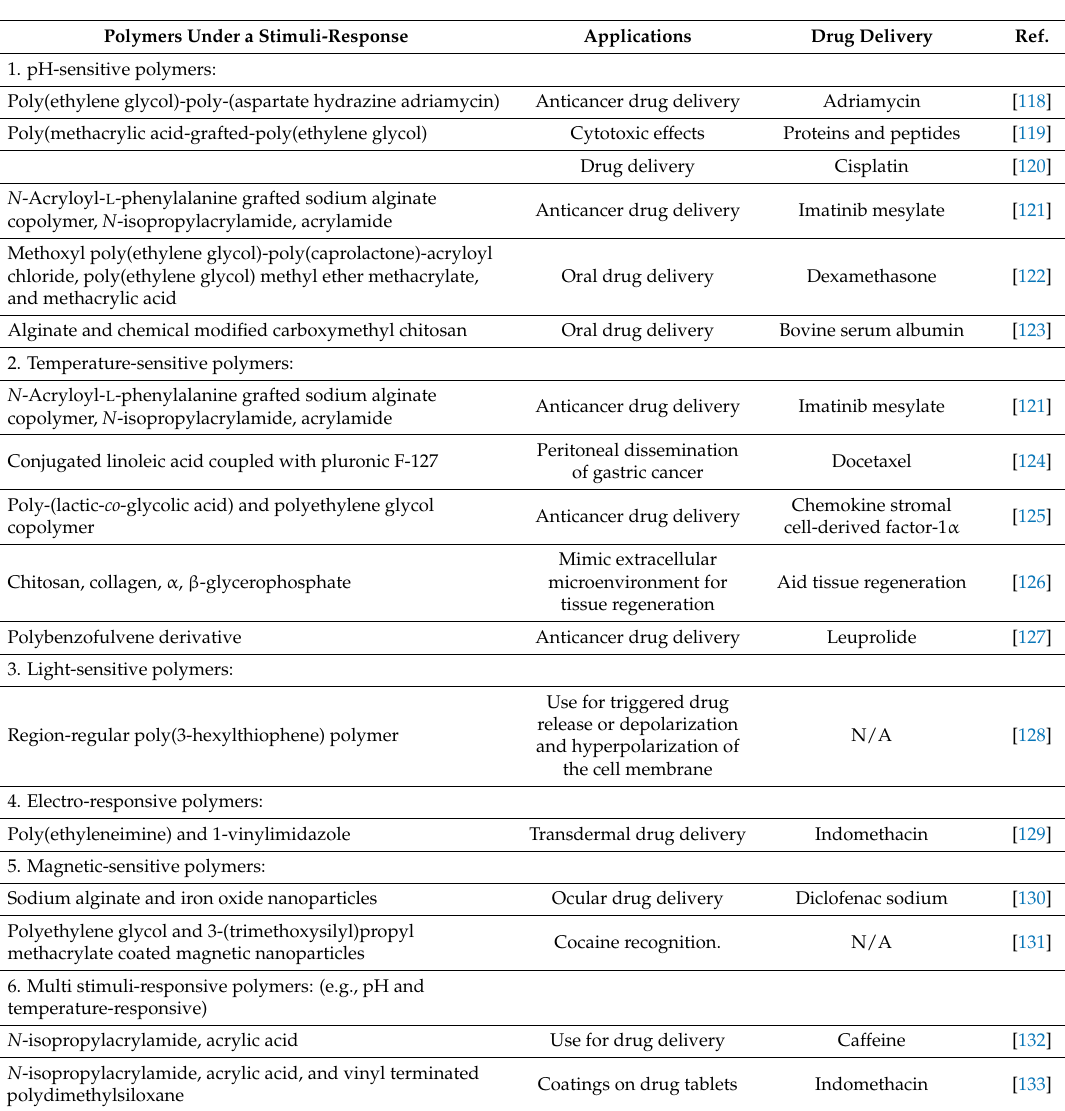
Table 2. Stimuli-responsive polymers for drug delivery